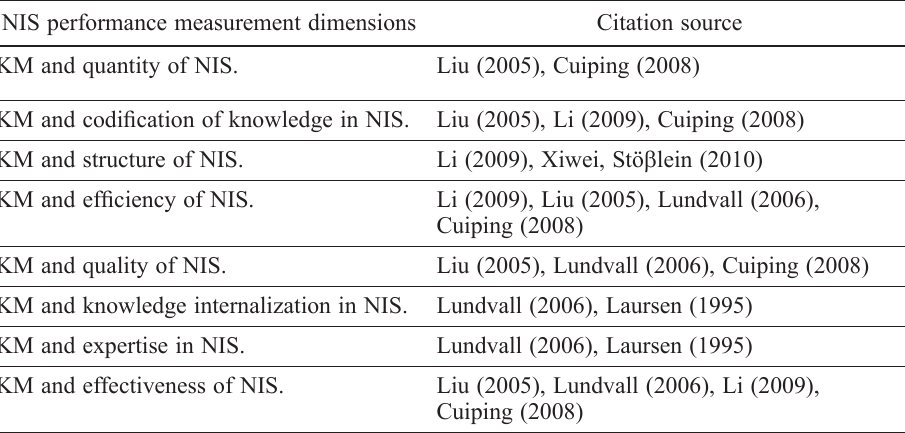
Table 1. Dimensions and factors of NIS performance measurement NIS performance measurement dimensions Citation source KM and quantity of NIS. Liu (2005), Cuiping (2008) KM and codification of knowledge in